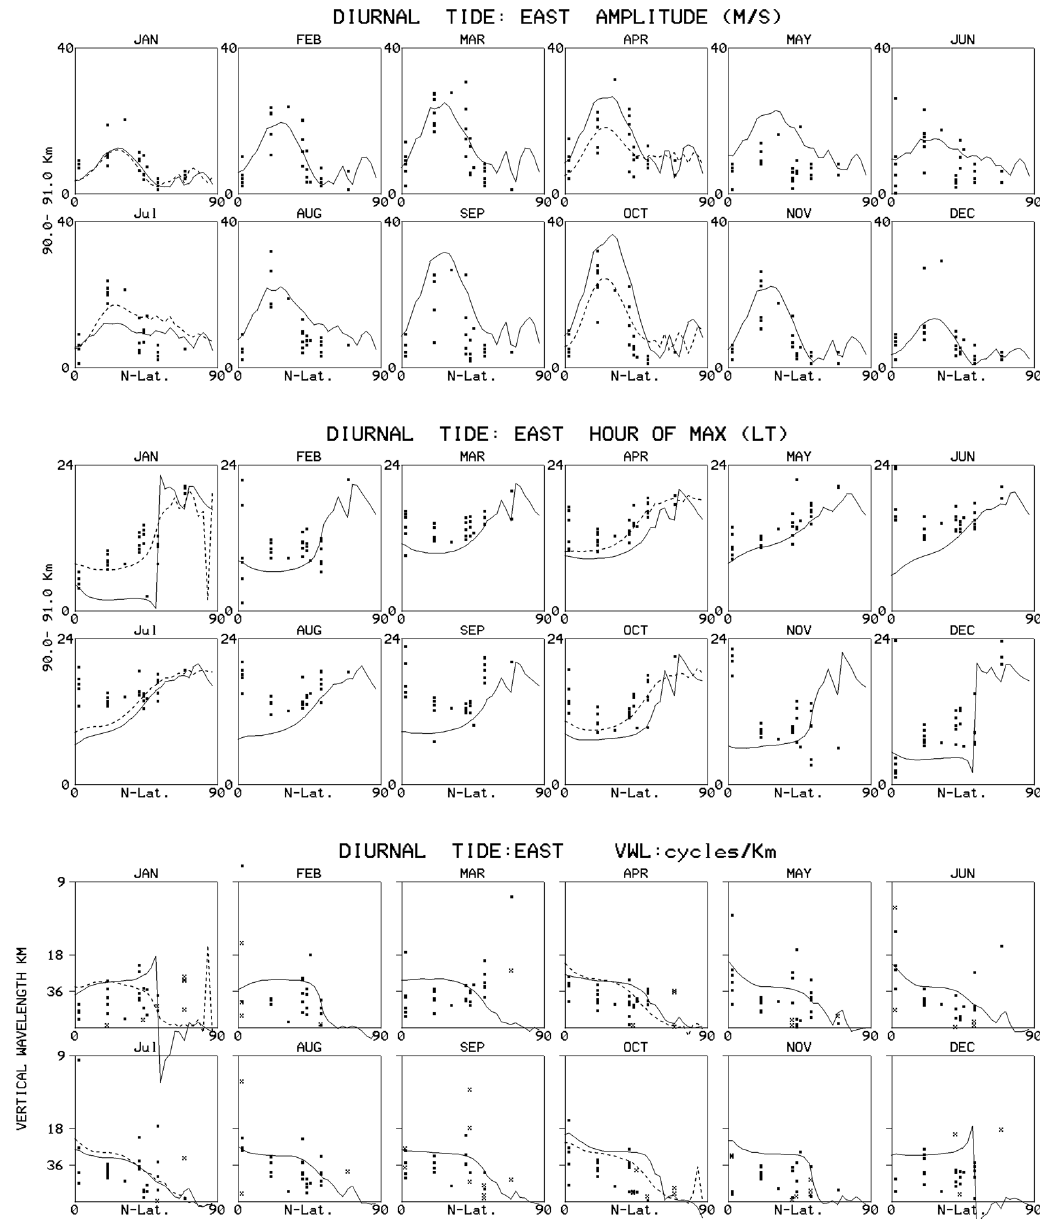
Fig. 8. Latitudinal plots for the Diurnal Tide (24h) near 90km. Otherwise as for Fig. 3.